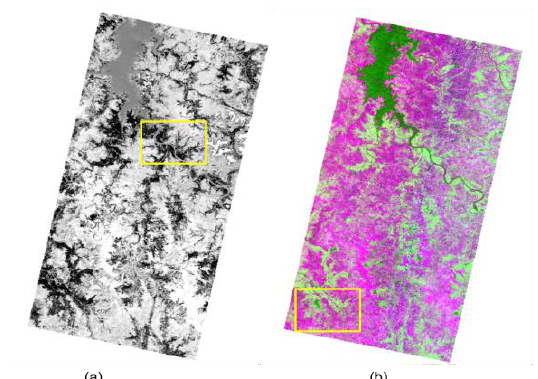
Figure 6. PRISMA datasets (a) PC 3 (b) PC Indices R=10 G=7